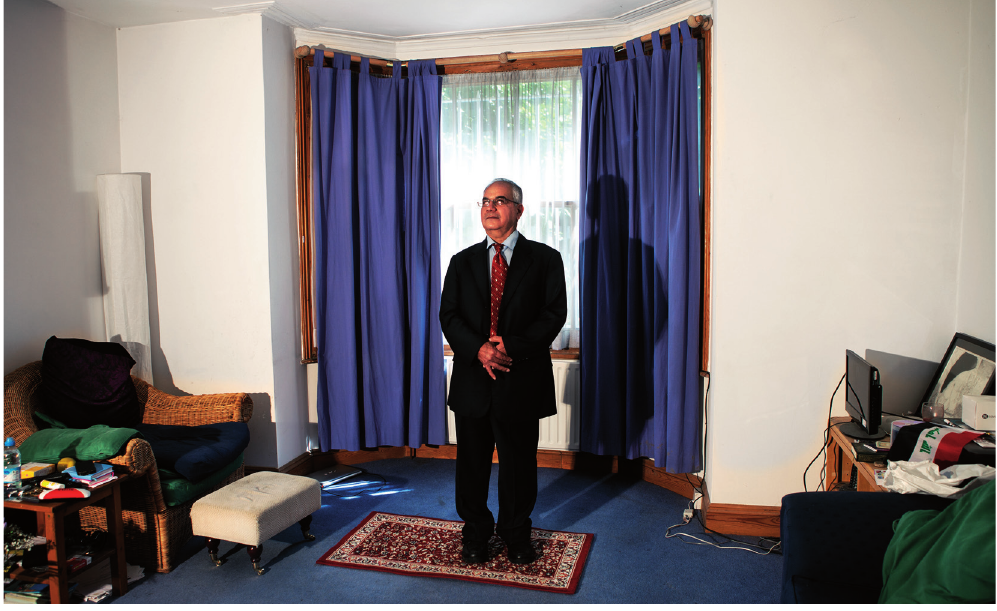
Figure 10: Jawad; from the series ‘The Journey’